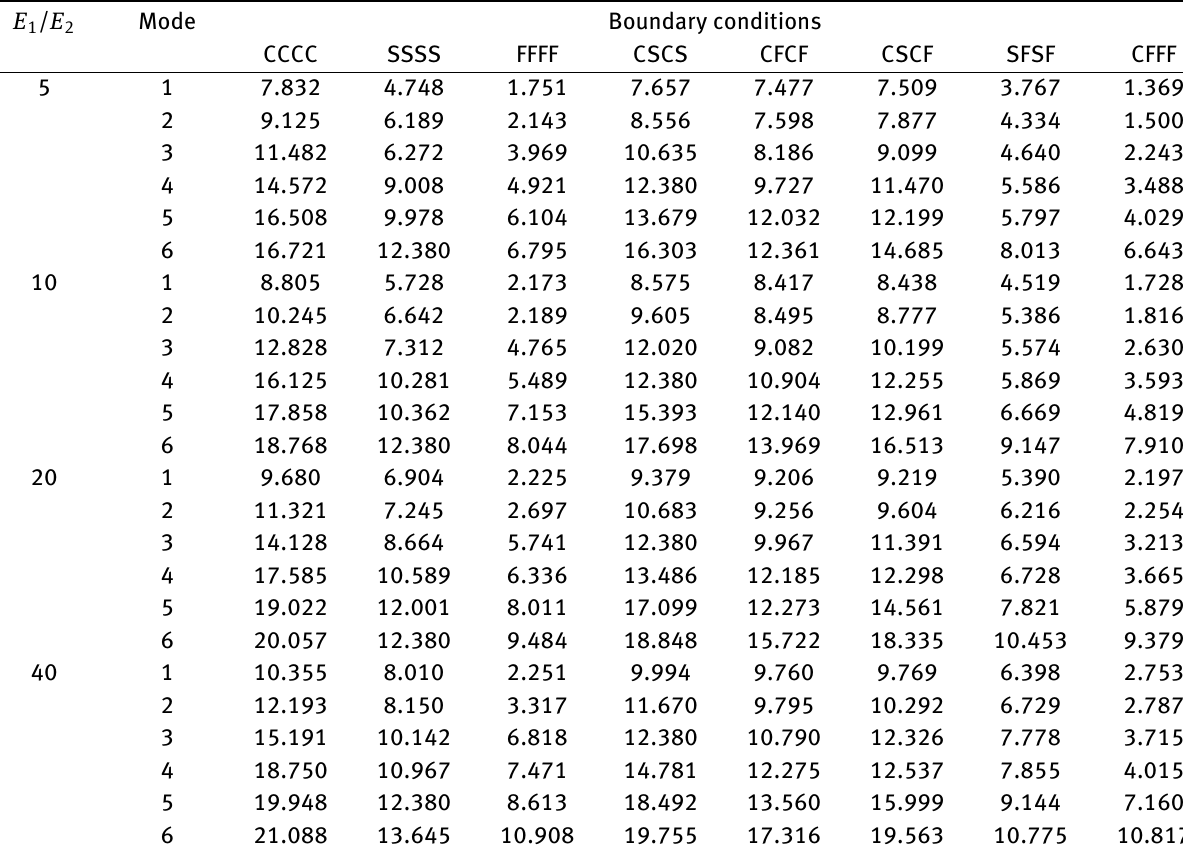
Table 4: Frequency parameters Ω for a [0 ∘ /90 ∘ /0 ∘ /90 ∘ ] laminated annular sector plate with different orthotropy ratios and boundary